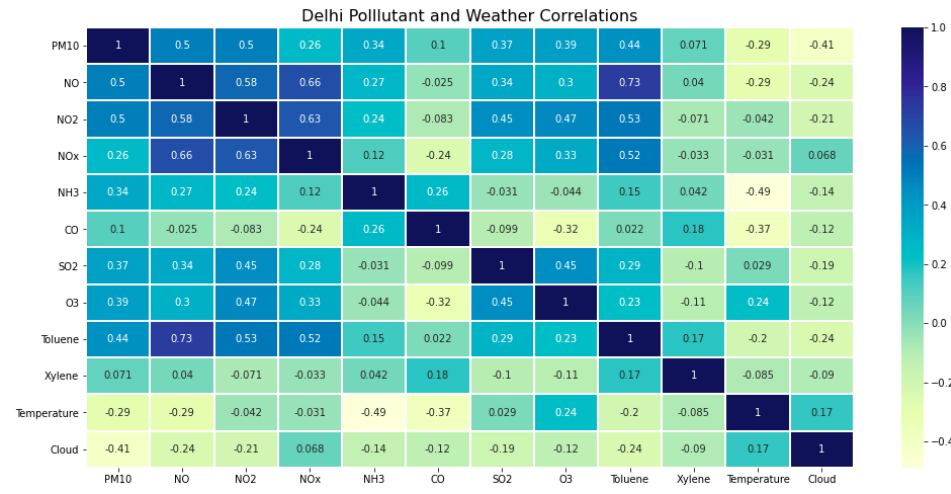
Figure 6. Correlation of each variable with all others for the year 2015. Some high values denote causal relationships, such as O 3 and NO 2 , while many others are simply emitted in